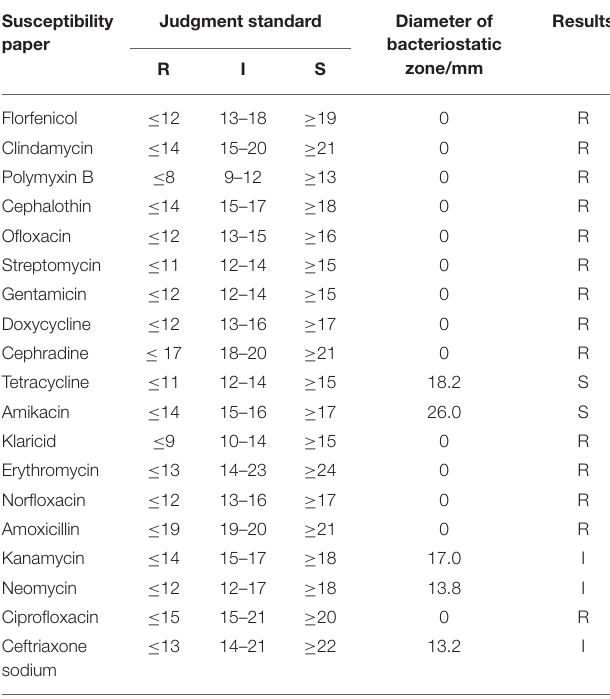
TABLE 4 | Antibiotic susceptibility of isolated